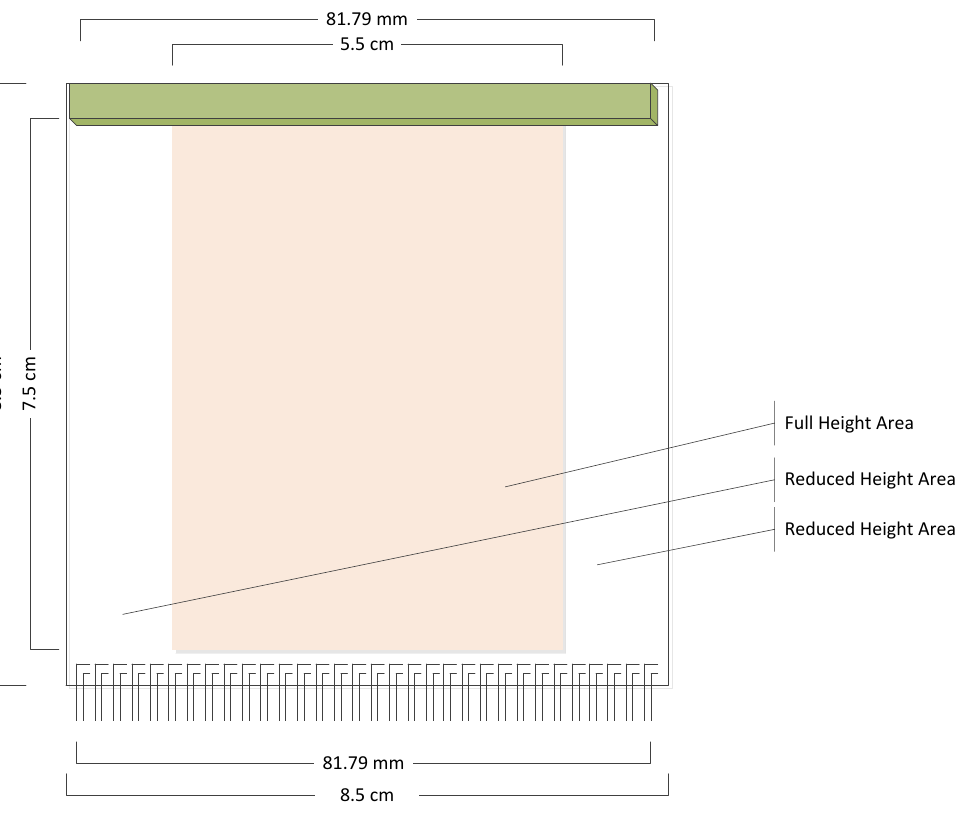
Figure 13. OPEN/OpenOrbiter Board Clearances (top